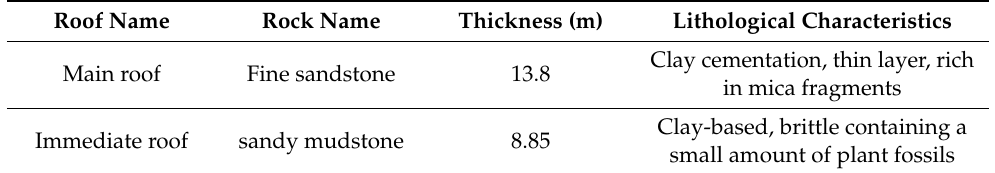
Table 1. Coal seam roof condition table.